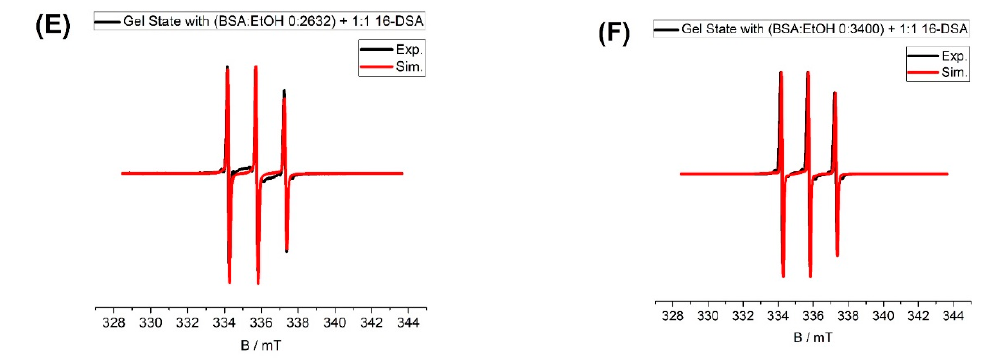
Figure A4. The samples are prepared based on Table A2. The data for ( E , F ) are shown in Table 2.